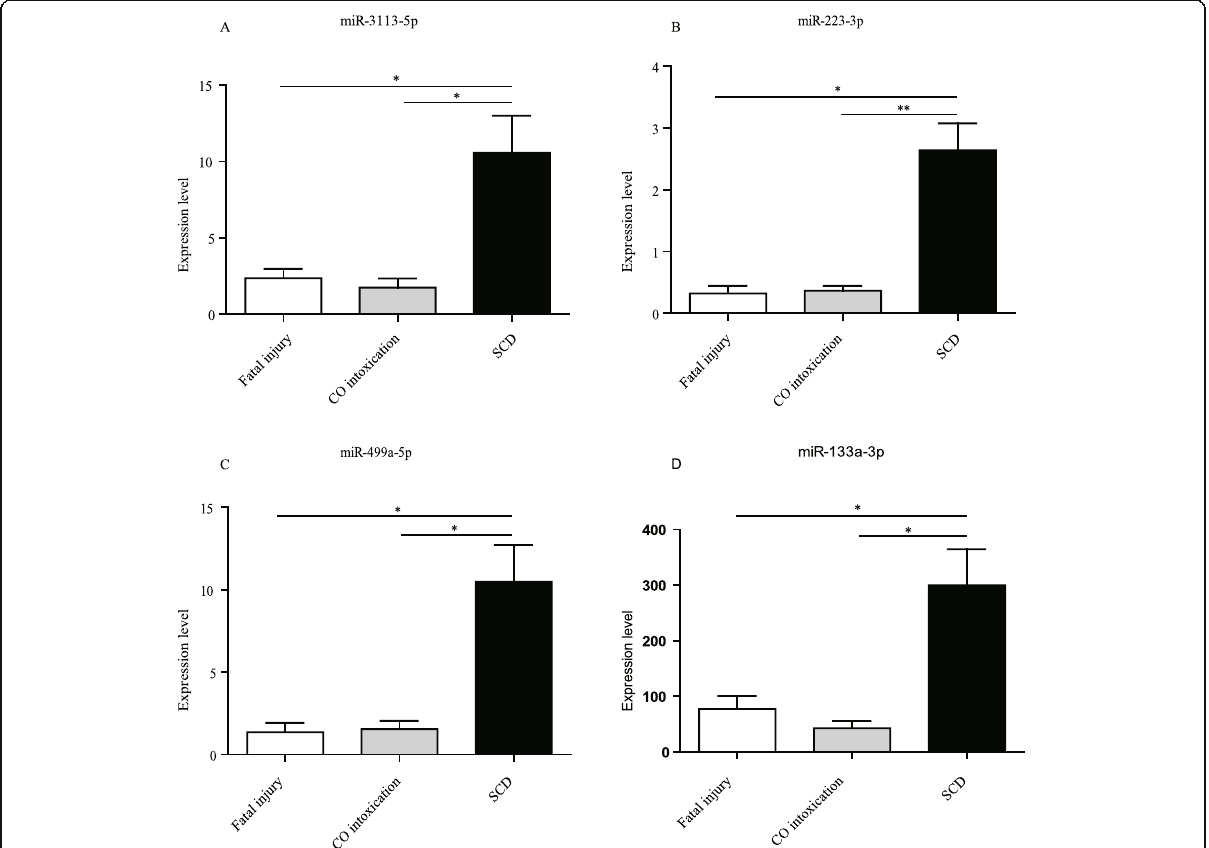
Fig. 3 The relative expression level of the four miRNAs among fatal injury ( n = 14), CO intoxication ( n = 14) and SCD groups ( n = 34). The expression of miR-3113-5p (A), miR-223-3p (B), miR-499a-5p (C) and miR-133a-3p (D) were detected by RT-qPCR. Results were normalized with U6 gene, * p < 0.05, ** p <